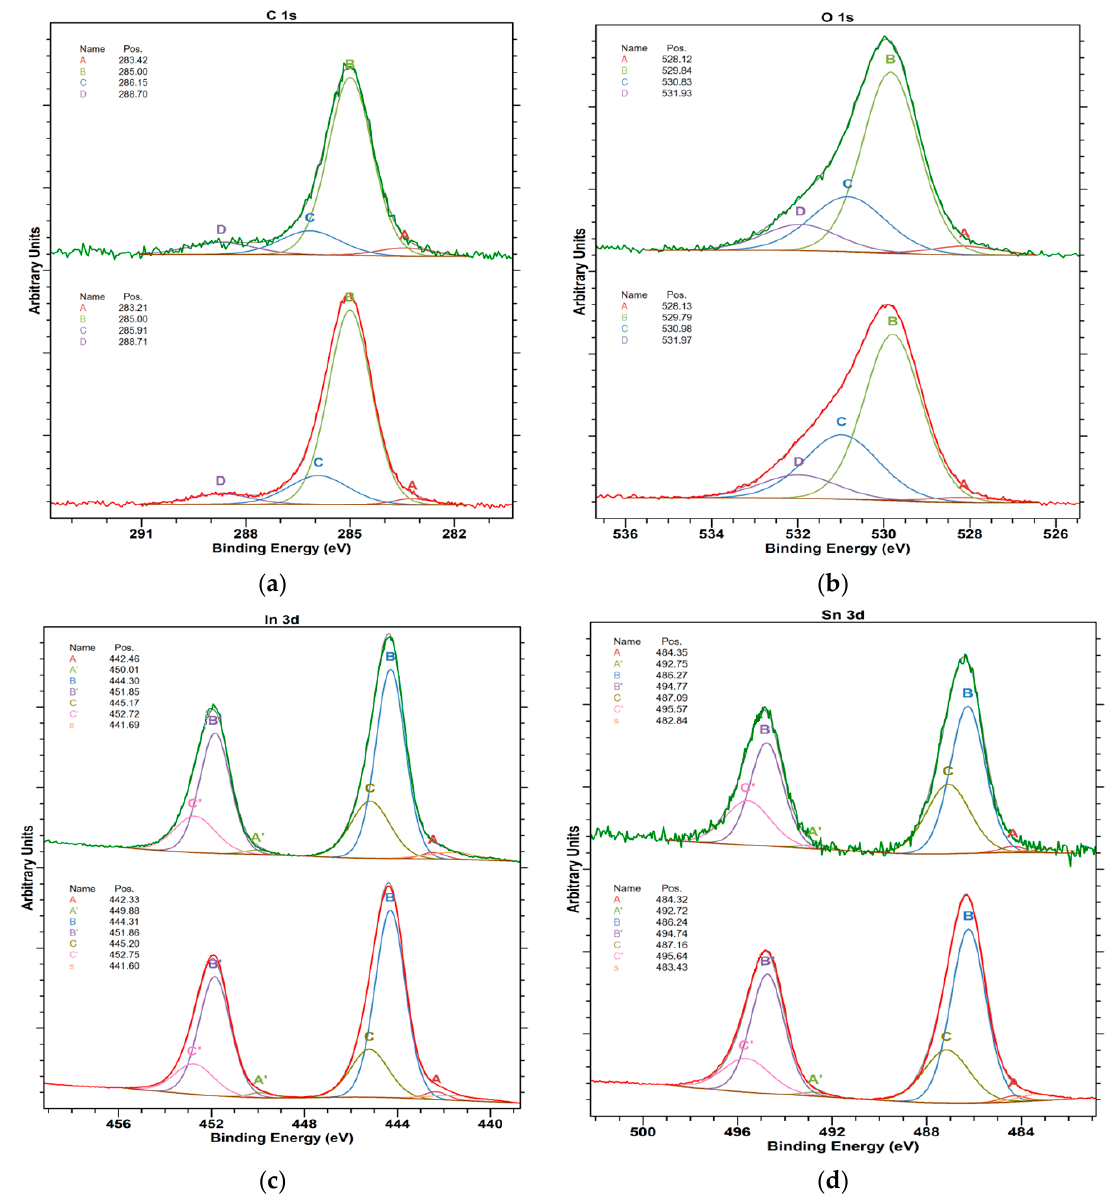
Figure 5. High-resolution XP spectra of ITO layers ( a ) C 1s (A: C-metal; carbon-metal bonding, carbides, B: C-C; organic carbon, the BE suggests that it can be sp2 in the majority, C: C-O; alcohol or ether groups, D: COOH, carboxylic or peptide groups), ( b ) O 1s (A: O-metal, defected oxide structure, presence of oxygen vacancies, B: O-metal, lattice oxides, C: OH, hydroxyl groups at the surface, D: O-C + H 2 O, organic compounds and water, oxygen bonded to short aliphatic chains + adsorbed water), ( c ) In three dimensions (A: In-C; surface carbides, B: In 3+- O; In 2 O 3 lattice oxide, C: In 3+- OH; In(OH) 3 , ( d ) Sn 3d spectra of 25 nm ITO (bottom) and 135 nm ITO (top) sample surfaces (A: Sn-C, tin carbides, B: Sn 4+- O; SnO 2 , C: Sn 4+- OH; Sn(OH) 4 )